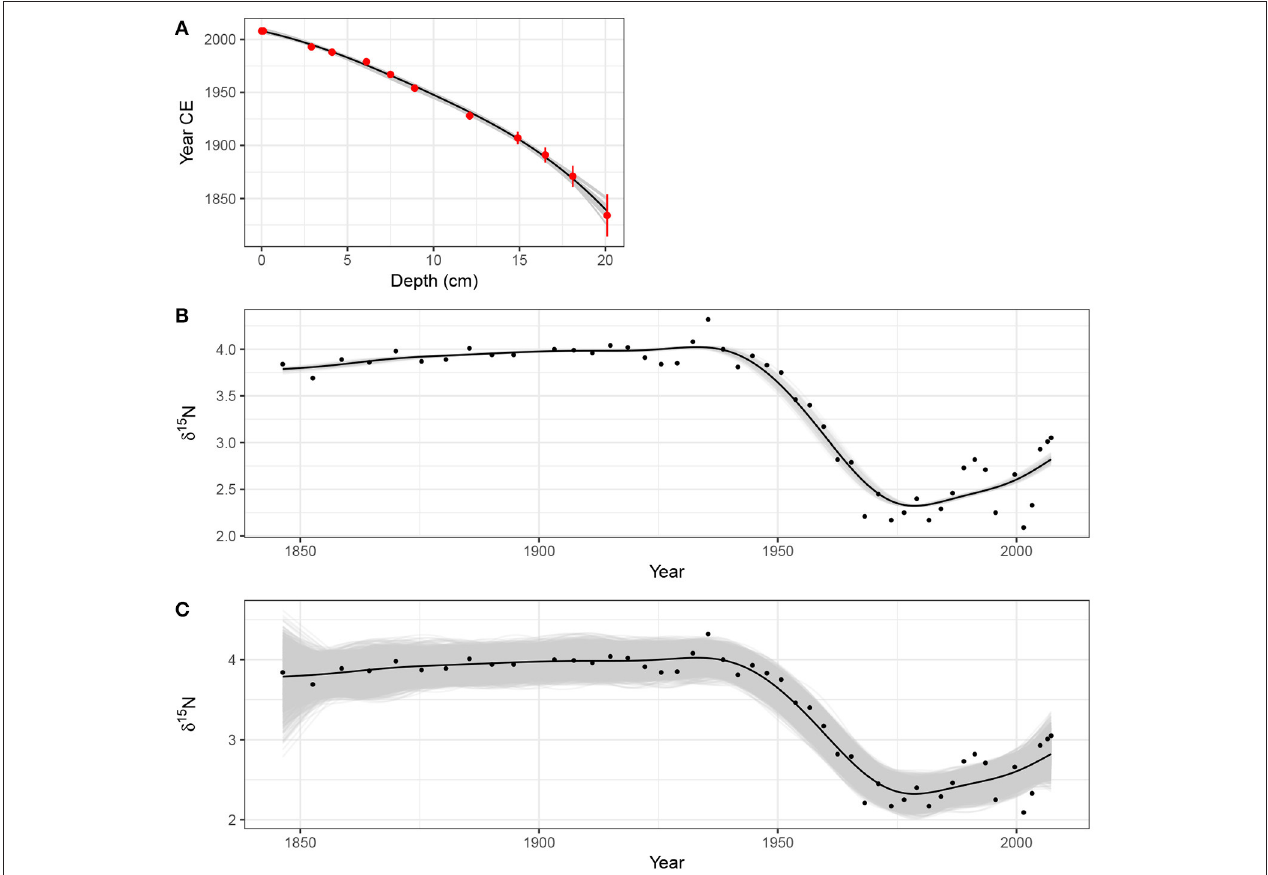
FIGURE 15 | Accounting for uncertainty in age estimates whilst fitting a smooth trend to the Small Water δ 15 N time series. (A) Estimated age model using a monotonically-constrained spline fitted to 210 Pb inferred ages for selected depths in the sediment core (red points). The uncertainty in the 210 Pb inferred age is shown by the red vertical bars. The fitted age model is illustrated by the solid black line. The faint grey lines are 25 random draws from the posterior distribution of the monotonically constrained GAM. The effect of age uncertainty on trend estimation is shown in (B) ; for 100 simulations from the posterior distribution of the age model in (A) a trend was estimated using a GAM with a thin plate regression spline basis and a CAR(1) process in the residuals. These trends are shown as grey lines. The combined effect of age model and fitted GAM uncertainty on the trends for the δ 15 N time series is shown in (C) . The grey lines in (C) are based on 50 random draws from the model posterior distribution for each of the 100 trends shown in (B) . For both (B,C) the black line shows the trend estimated assuming the ages of each sediment sample are known and